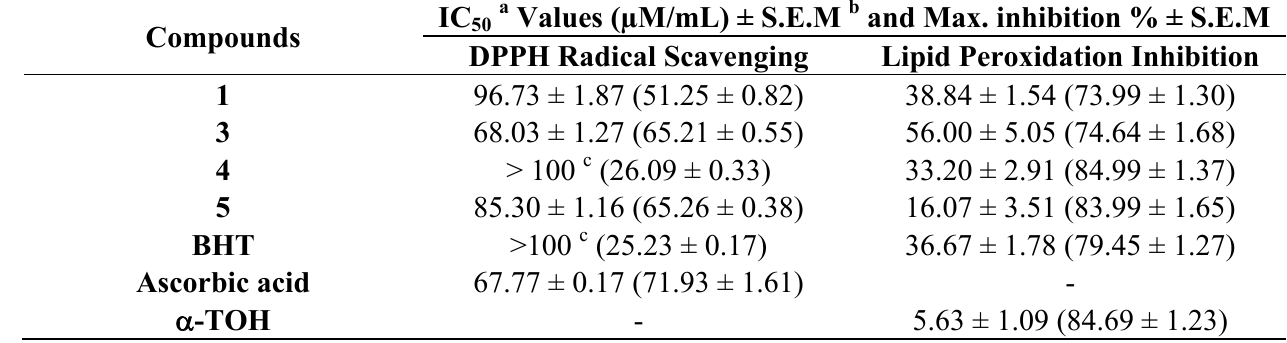
Figure 6. Phenylthiourea system. Sthione NHN H